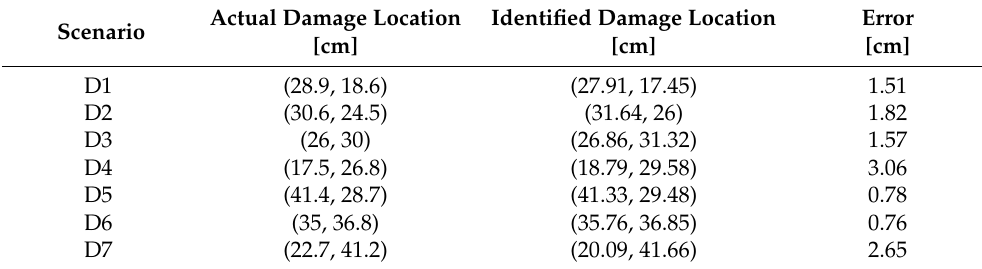
Table 1. Comparison of the actual damage location and identified damage location.